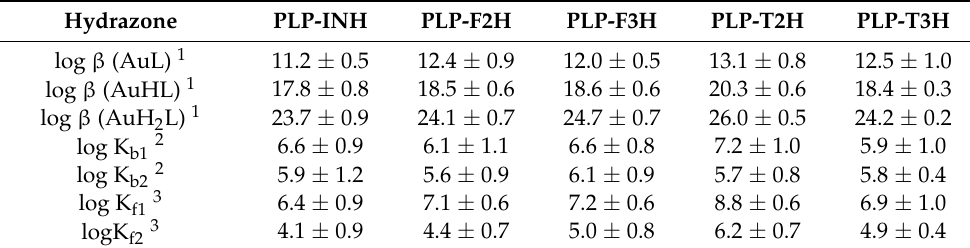
Table 1. Stability constants of gold(III) complexes with hydrazones derived from pyridoxal 5 (cid:48) -phosphate in aqueous solution at T = 298.2 K, I ~